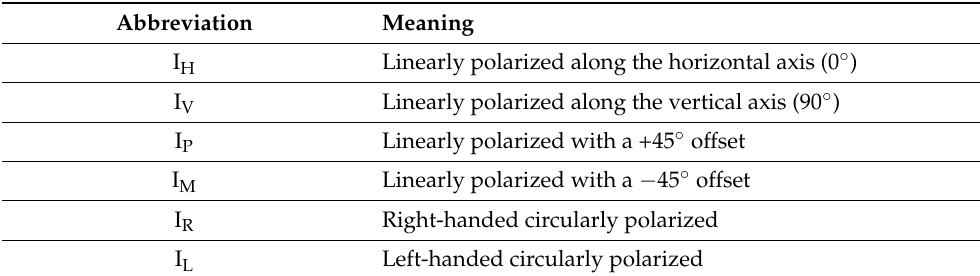
Left-handed circularly